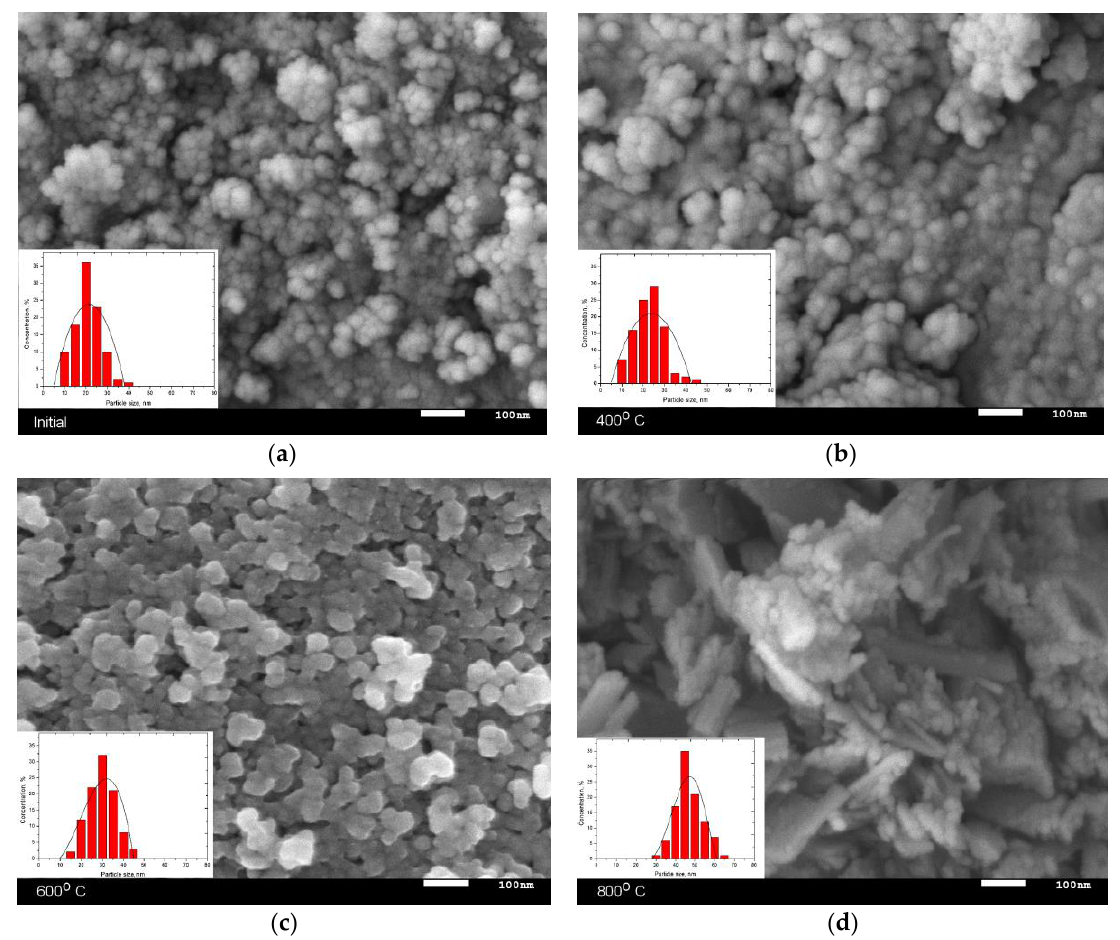
Figure 1. Dynamics of change in the geometric parameters of nanoparticles according to scanning electron microscopy (SEM) image data: ( a ) initial; ( b ) 400 °C; ( c ) 600 °C; ( d ) 800 °C.